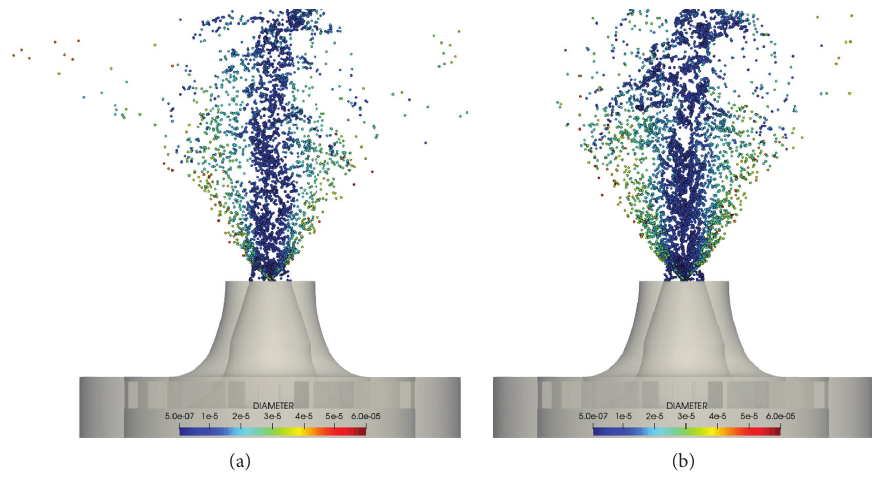
Figure 20: Droplet diameter for cases A-R (a) and B-R